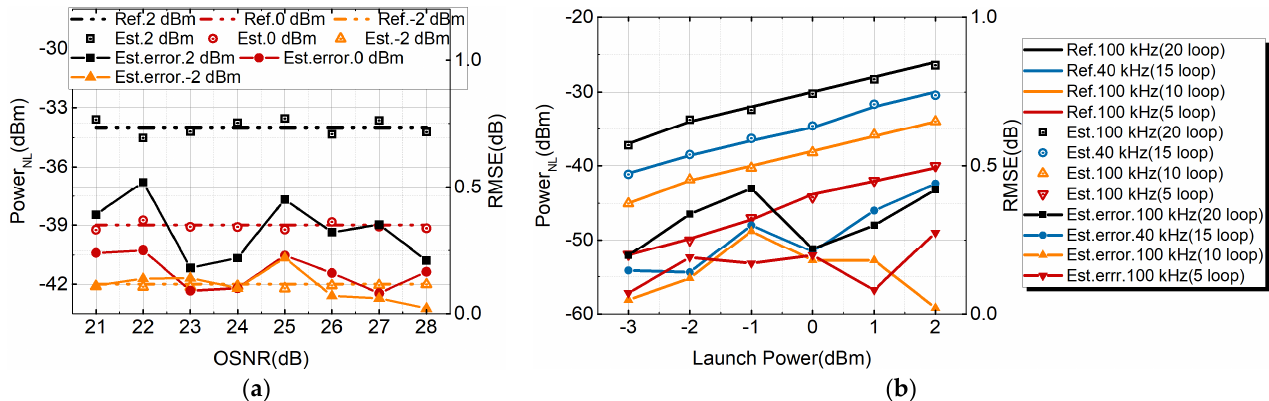
Figure 10. ( a ) Estimated NL noise power and error under different OSNR of 800 km PDM-32QAM. ( b ) Estimated NL noise power with different linewidth and transmission distance for 32QAM system.